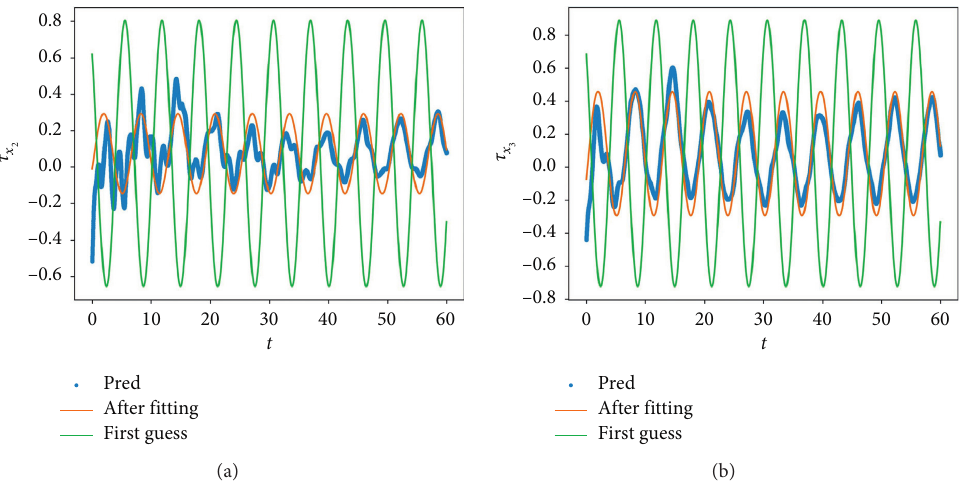
Figure 5: The prediction results of the unbalanced forces and their harmonic fits: (a) the results at correction plane 1 and (b) correction plane